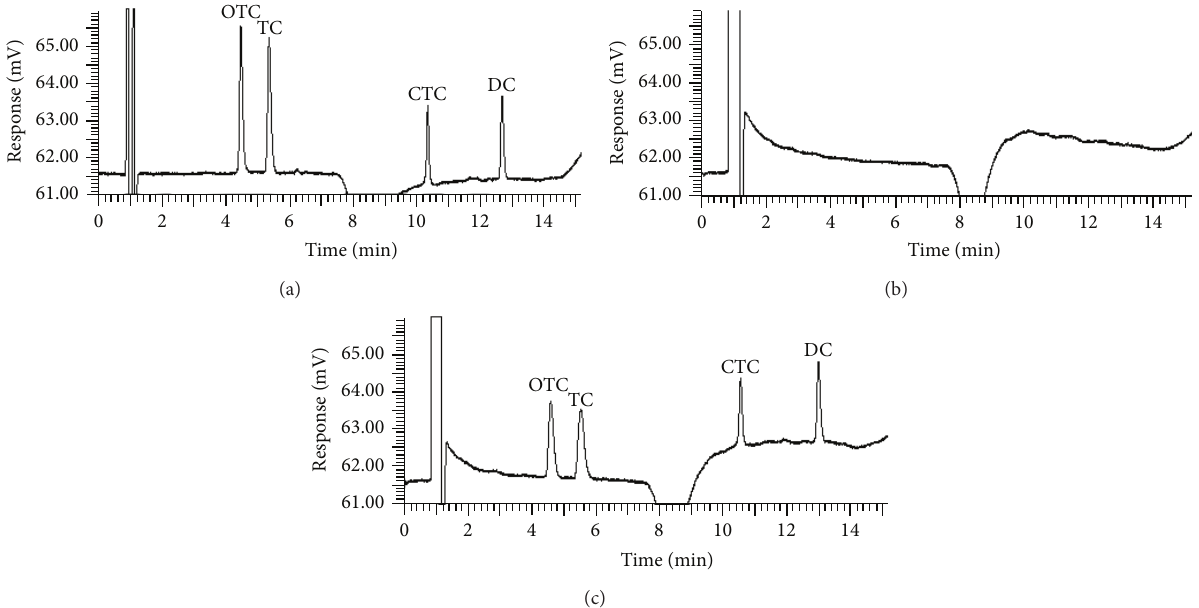
Figure 4: HPLC chromatograms obtained by UV detection (355 nm) of (a) standards of 1.0 𝜇 g/mL TCs in pure water, (b) blank manure sample extract, and (c) blank manure spiked with 50 𝜇 g/g TCs.